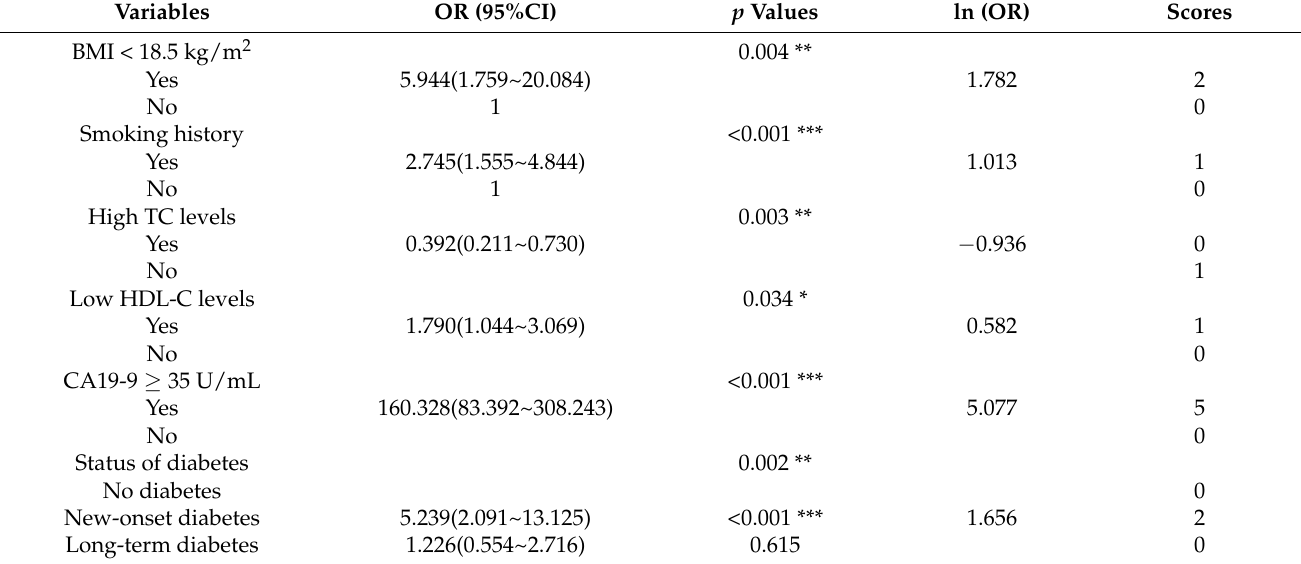
Table 4. Determination of the scores for each factor in the PC screening scale.